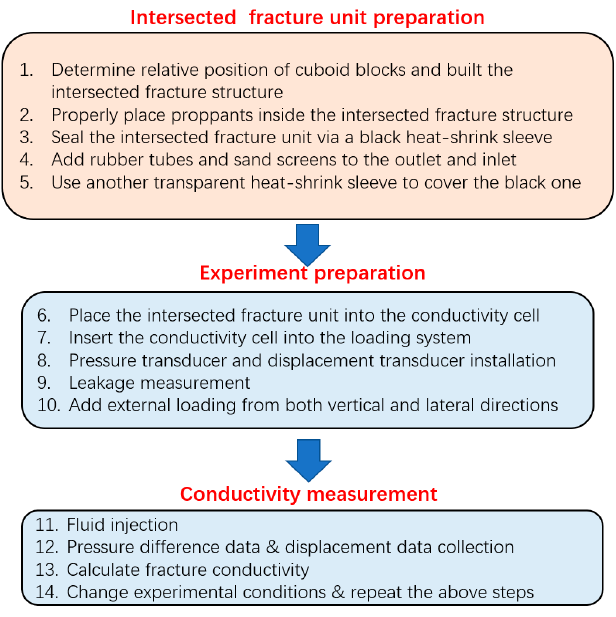
Figure 5. Flow chart for the complete conductivity measurement process.